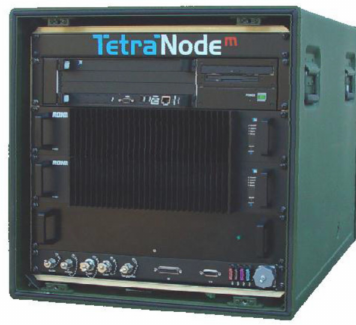
Figure 9. Bio-Garden exercise: Rohill TetraNode equipment (TETRA base station) tested during the